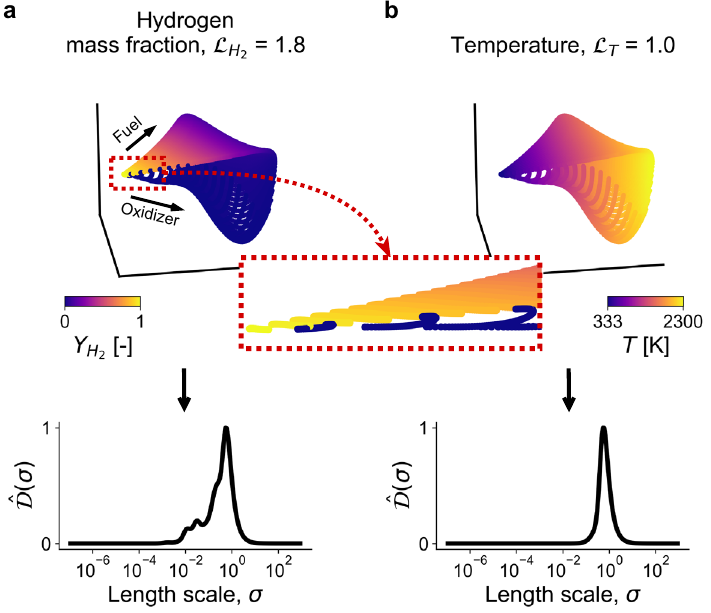
Figure 5. Example 3D manifold in a reacting flow dataset describing combustion of hydrogen in air. ( a ) The manifold exhibits region (marked with the red dashed box) with a step-change in hydrogen (fuel) mass fraction values, Y H 2 . ( b ) For comparison, the temperature variable, T , on the same manifold does not experience large variation within the considered region and the cost associated with the temperature variable is